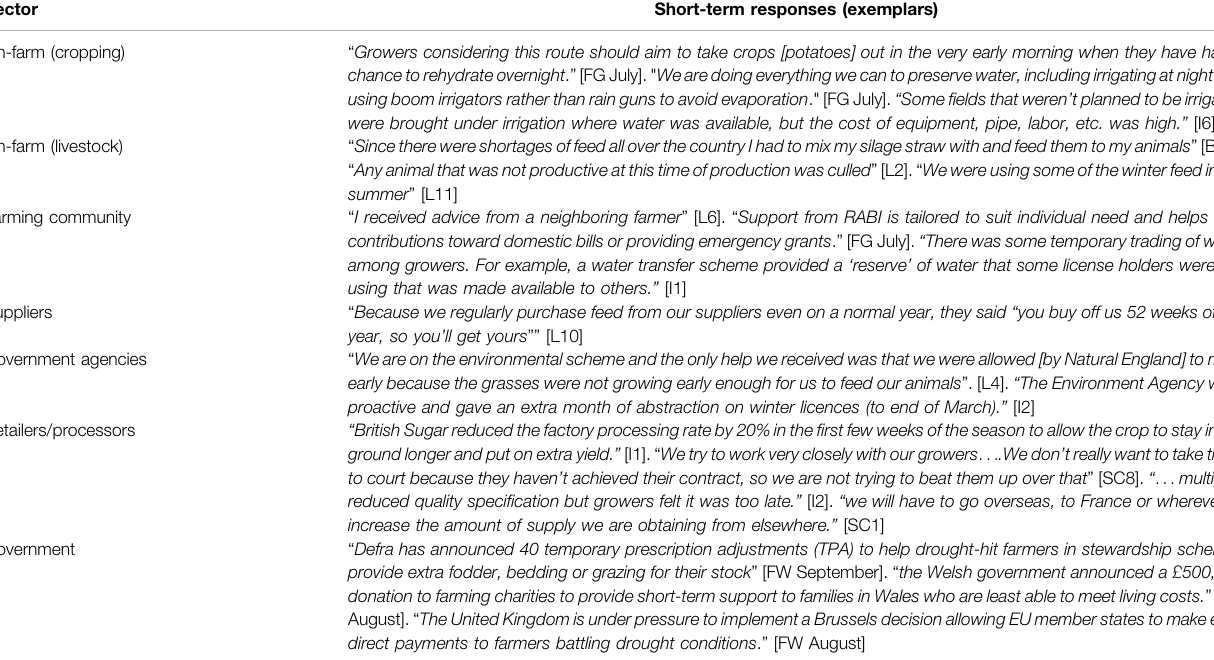
TABLE 1 | Exemplar reported short-term responses to drought impacts across the United Kingdom farming sector. Sector Short-term responses